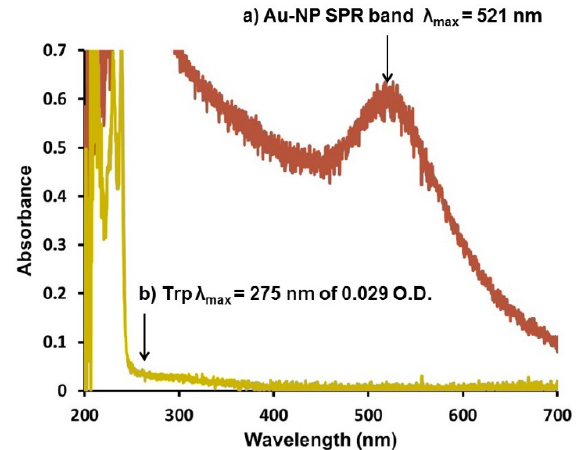
Figure 6. Representative UV-Vis spectra of Au-GSH-(Trp) = 521 nm) ( a ) before and ( b ) 20 min after cyanide (15.3 mM) addition in 10 mM λ max sodium phosphate buffer at pH